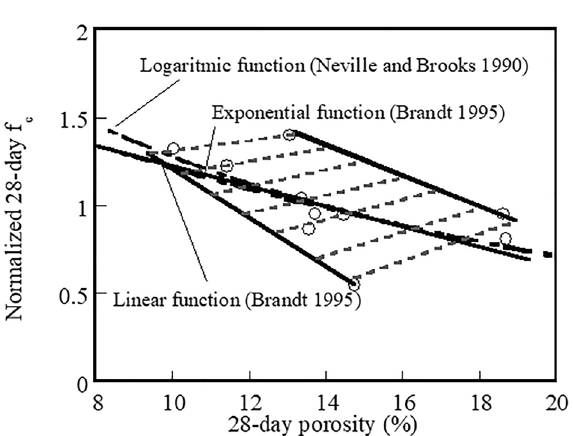
Figure 9. Relationship between normalized 28-day f c and 28-day porosity of control systems and systems containing 20% and 50% fly ash mixed at different mixer revolution counts.